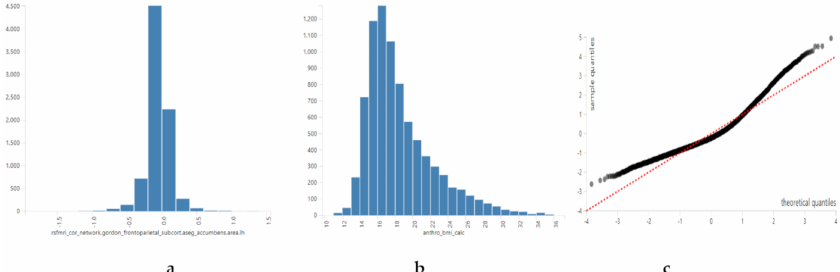
Figure A1. Assumptions for mixed-e ff ects models for replication models. ( a ) histogram of the predictor (NAc functional connectivity with the frontoparietal network), ( b ) histogram of the outcome (baseline body mass index; BMI), ( c ) observed vs. theorized